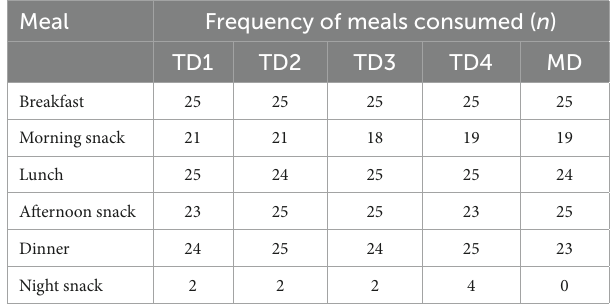
TABLE 2 Frequency of meal intake per